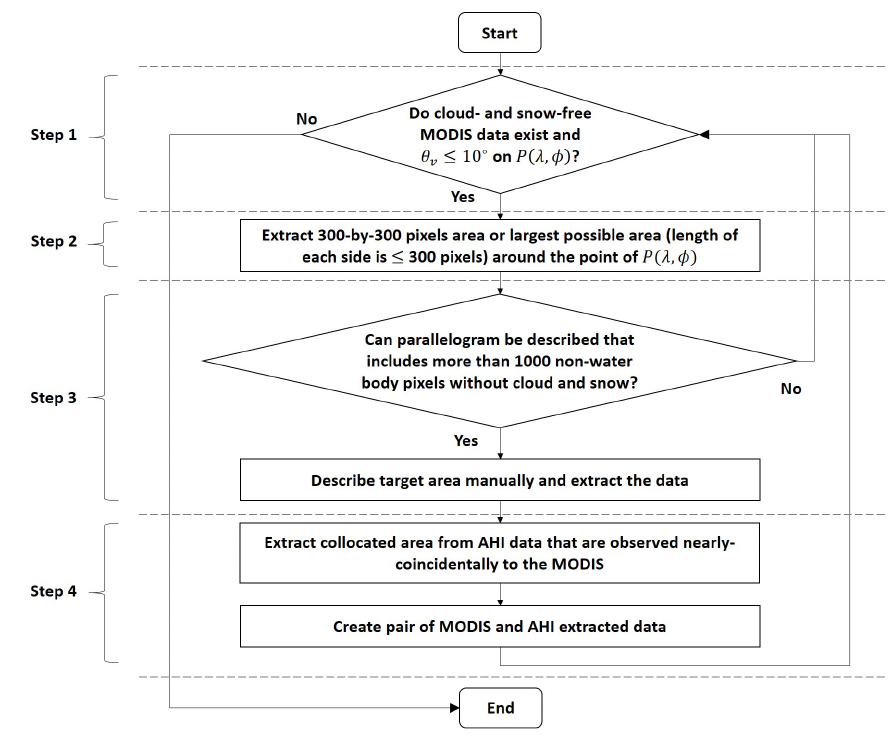
Figure 4. Flowchart for creating pair of MODIS and AHI data.